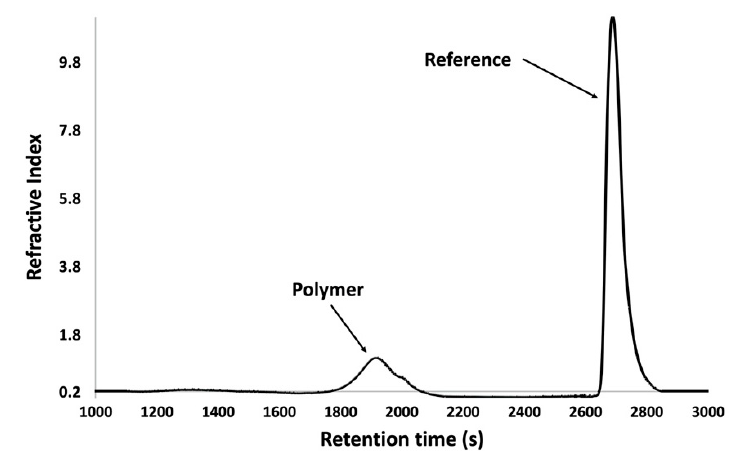
Figure 5. SEC curve relative to the purified product. The polymer and reference peaks are highlighted.